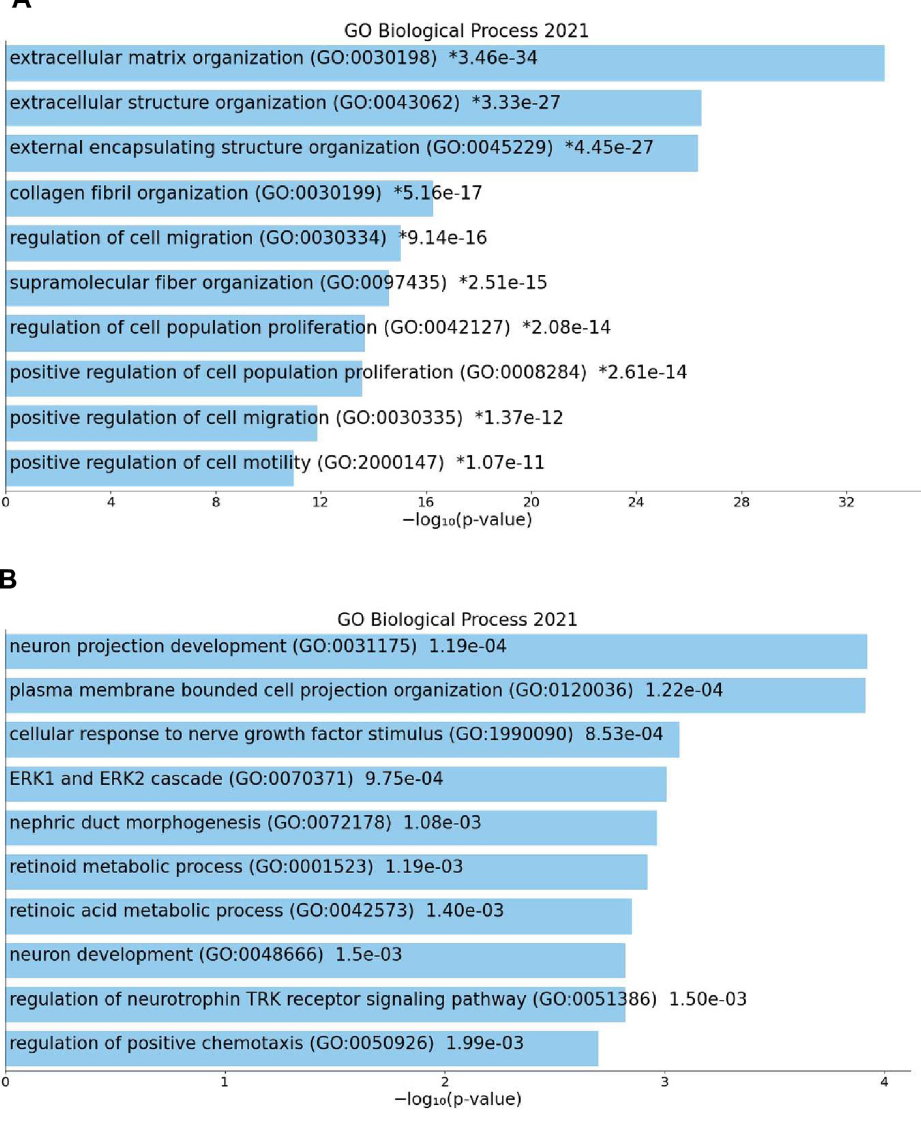
Wilms cell lines. A higher expression of the other PTA markers, JAG1 and CCND1 is observed in the Wilms cell lines but WNT4 is not expressed. Several markers distinguish distal and prox- imal RV, e.g., SFRP2 , DLL1 , LHX1 and CDH6 , FOXC2 , CLDN1 and WT1 , respectively. Most of these vary between cells and have a low level, except for a robust expression of the podocyte marker FOXC2 , and DLL1 is not expressed. Genes that are expressed in the Wilms cell lines from the next developmental stages are, SSBpr: CAV2 , CDH6 and AMN , SSBm/d: IRX2 , POU3F3 and SIM2 , and SSBpod: XRCC6 , FOXC2 and MAFB . This is followed by more differ- entiated cell types, and the genes that are expressed in the early proximal tubule (ErPrT) are AMN , APOM and ANPEP and from distal loop of Henle (DTHL) are LDHB and HOXD8 .